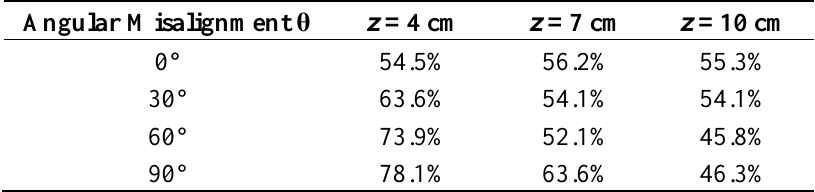
Table 2. Effective